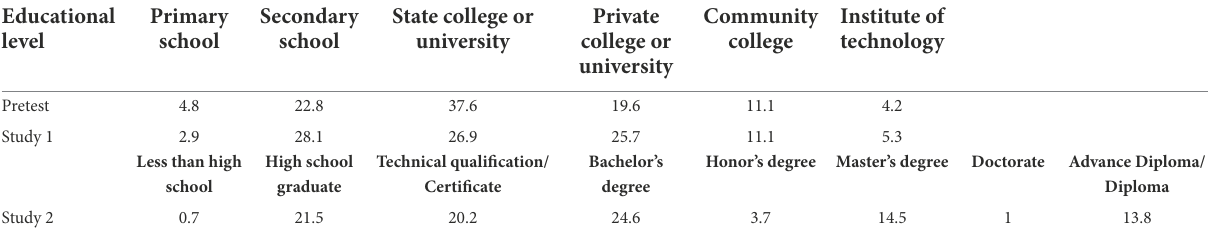
TABLE 2 Frequency of educational levels for pre-study, Study 1 and Study 2 provided in percentages. Educational